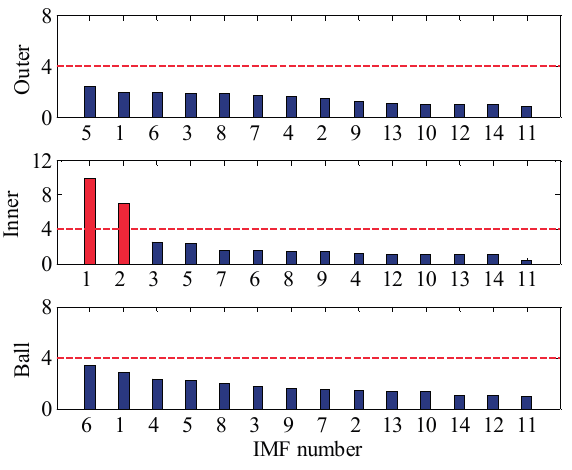
Figure 23. FSM of locomotive bearing signal.